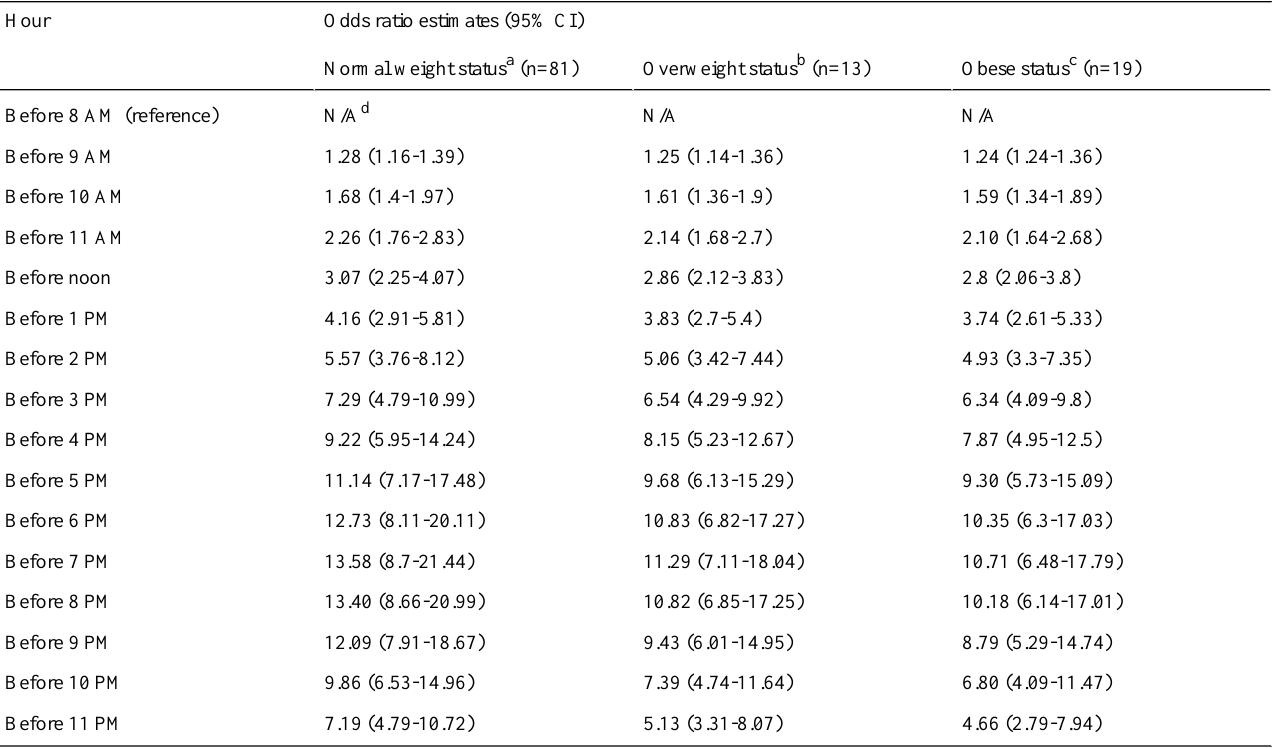
Table 3. Moderating effect of BMI on odds ratio estimates of time of average moderate-to-vigorous physical activity accumulation. Odds ratio estimates (95%